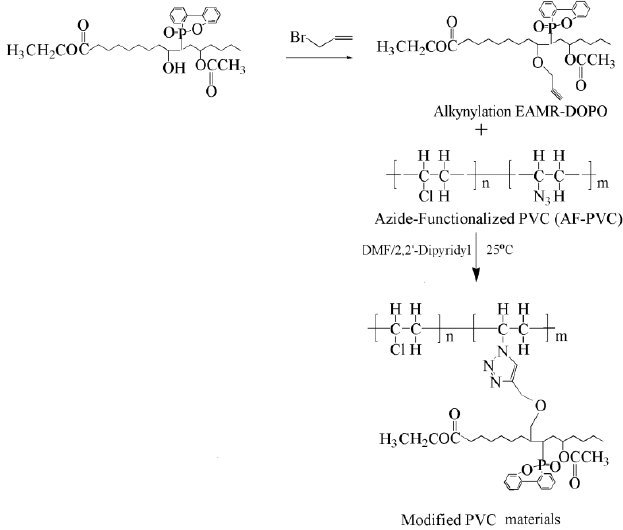
Figure 26. Synthesis internally plasticized PVC with alkynylation EAMR-DOPO.